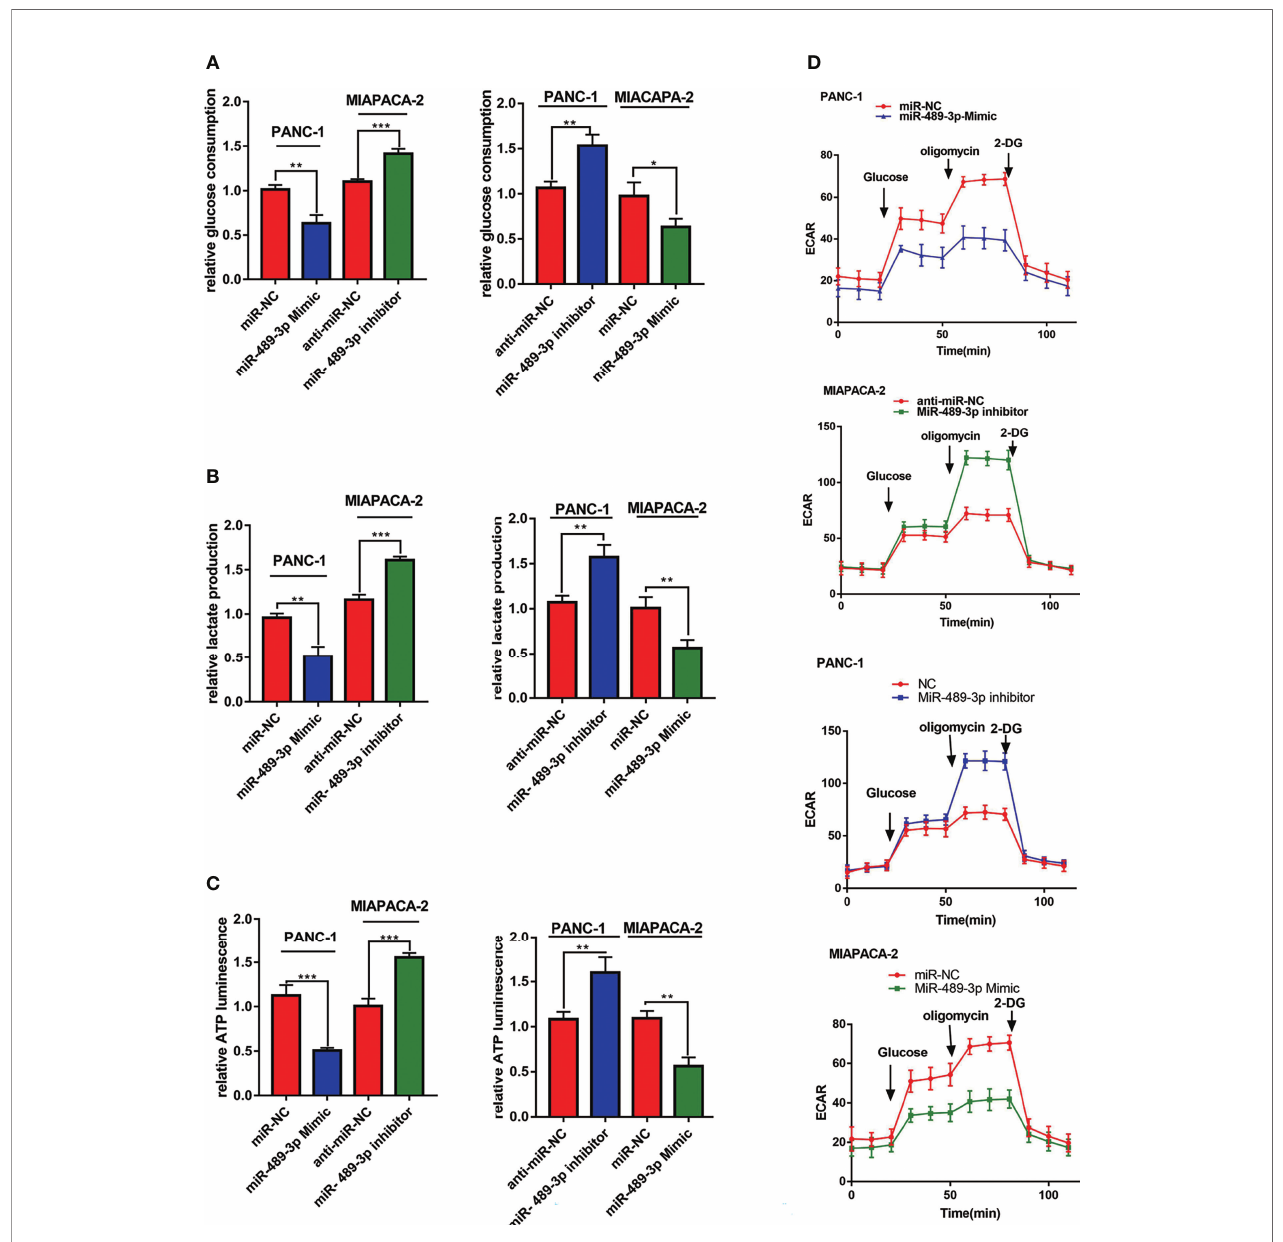
FIGURE 4 | MiR-489-3p regulates PC glycolysis. (A – C) Cell metabolism experiments showed glucose uptake, lactic acid production, and ATP production of miR-489-3p mimics and miR-489-3p inhibitors in PC cells. (D) The hippocampal XF extracellular fl ux analyzer analysis of the PC ECAR in miR-489-3p mimics and inhibitors group. (*P < 0.05, **P < 0.01, ***P <